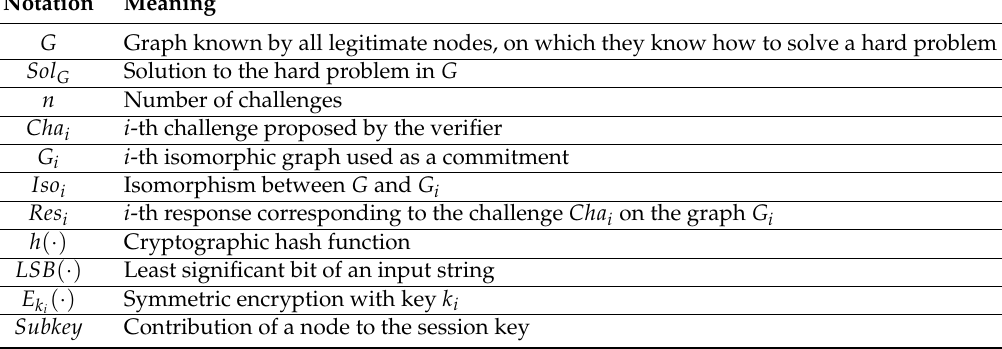
Table 1. Proposal parameters.